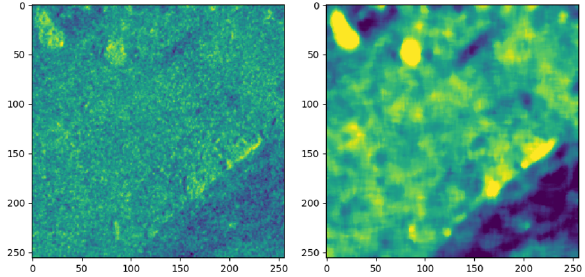
Figure 2: Example of raw Sentinel-1 SAR image (left). The cor- responding processed Sentinel-1 SAR image (Right)